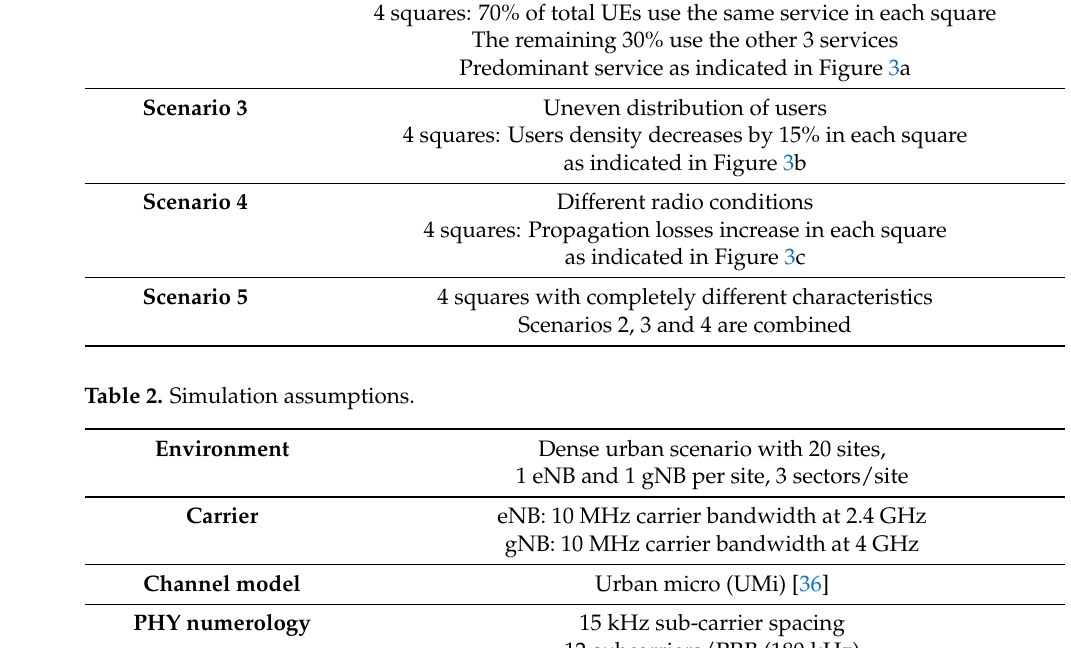
Table 1. Configuration of the scenario for each test.